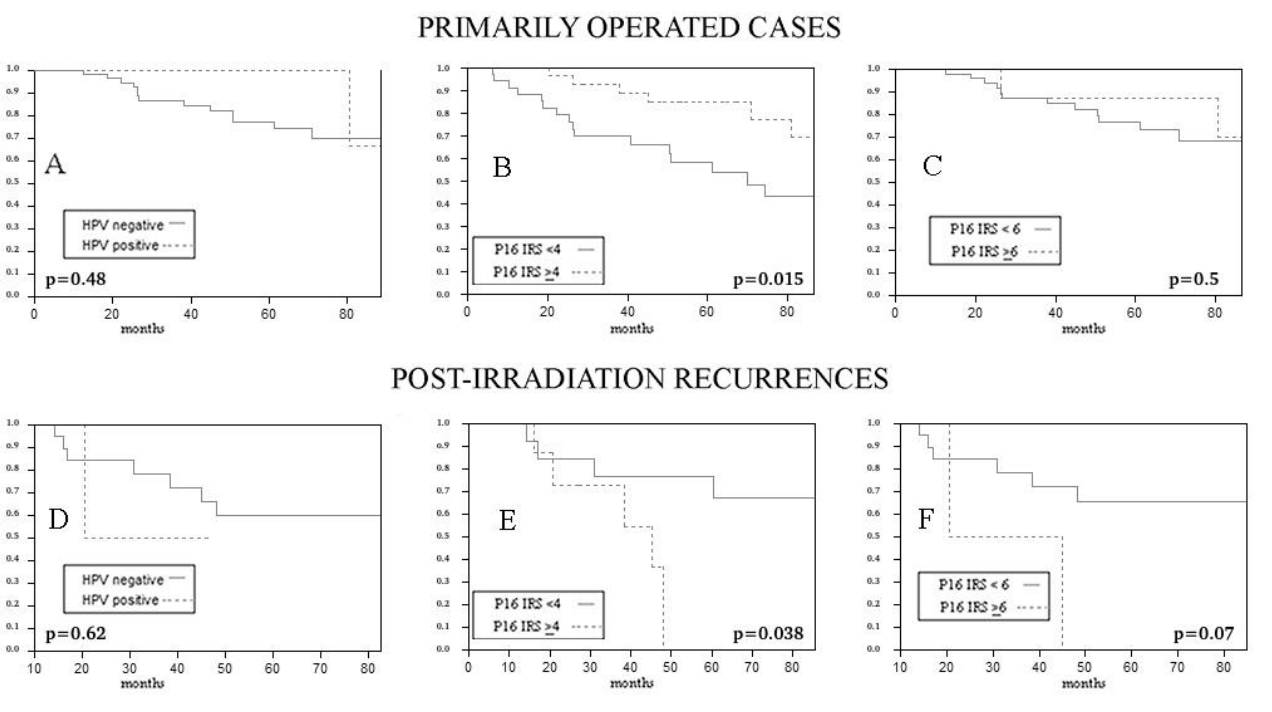
Figure 3. Impact of HPV DNA (( A ) p = 0.64 at Log-Rank) and of p16 expression (( B ) IRS ≥ 4 cut-off p = 0.21 at Log-Rank; ( C ) IRS ≥ 6 cut-off p = 0.97 at Log-Rank) on overall survival. Impact of HPV DNA (( D ) p = 0.86 at Log-Rank) and of p16 expression (( E ) IRS ≥ 4 cut-off p = 0.013 at Log-Rank; ( F ) IRS ≥ 6 cut-off p = 0.26 at Log-Rank) on relapse free survival of the overall series.